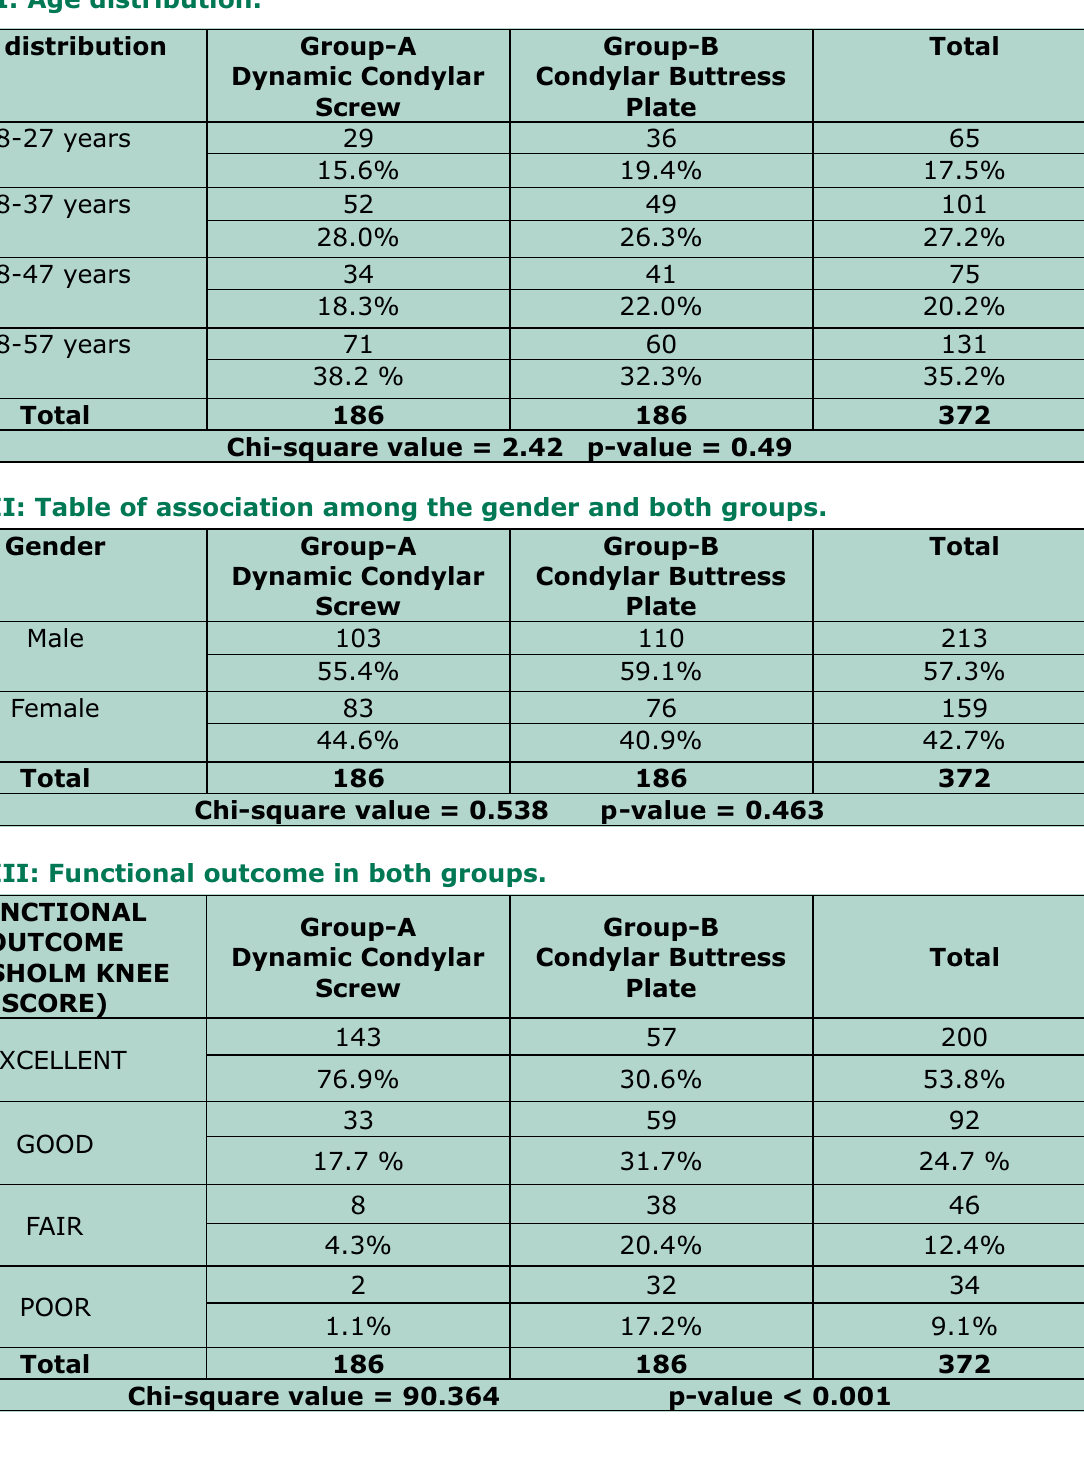
Table-I: Age distribution.